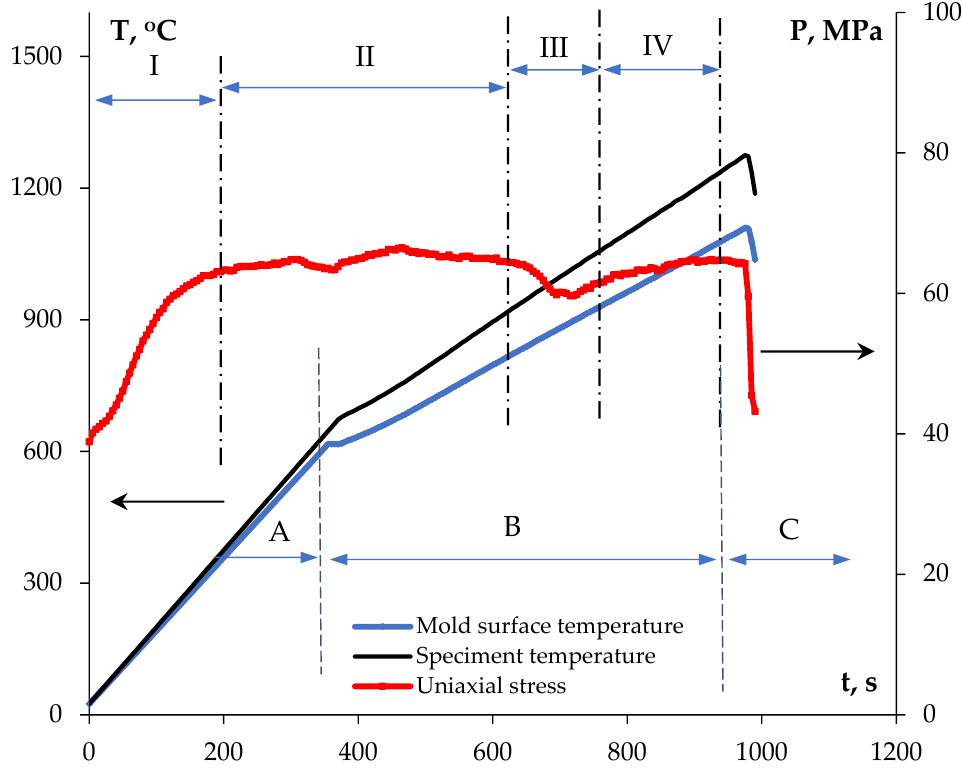
Figure 1. Regularsinteringdiagram“temperature-stress-time”forSPS.Na 0.7 Zr 2 (PO 4 ) 2.7 (MoO 4 ) 0.3 Figure 1. Regular sintering diagram “temperature-stress-time” for SPS. Na 0.7 Zr 2 (PO 4 ) 2.7 (MoO 4 ) 0.3 compound.